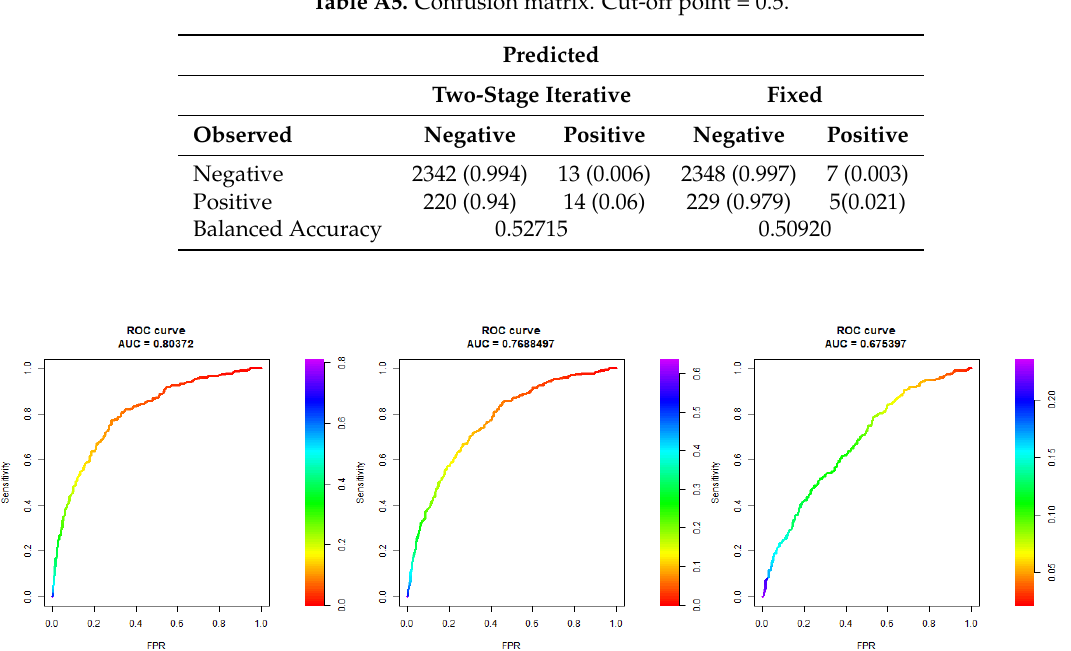
Table A5. Confusion matrix. Cut-off point = 0.5.